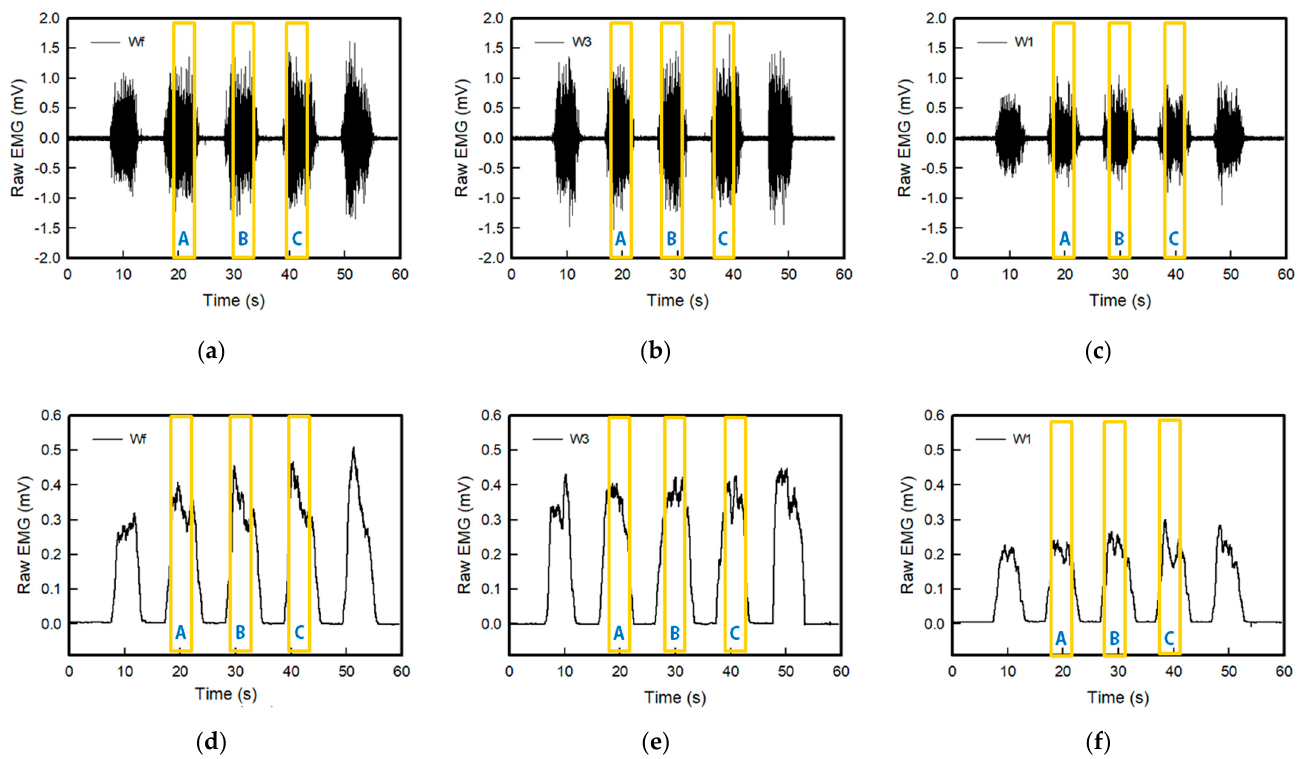
Figure 9. Graph of raw sEMG signals obtained via ( a ) Wf, ( b ) W3, and ( c ) W1 and filtered (20–500 Hz) in analog and full-wave of the sEMG signal of ( d ) Wf, ( e ) W3, and ( f ) W1, respectively; Here, the values of sections A, B, and C in the yellow box were used for EMG signal measurement and analysis.